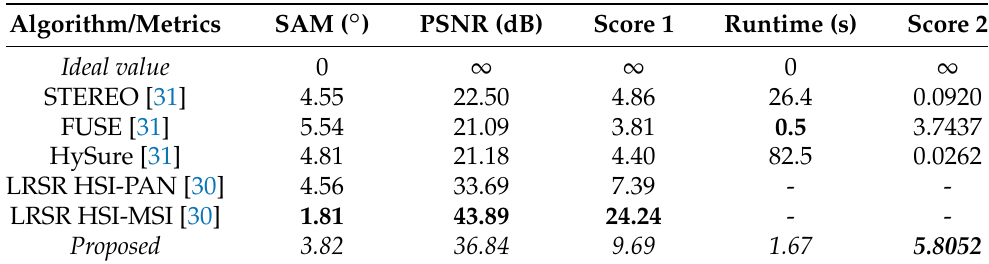
Table 2. Performance comparison of different SR algorithms on the Pavia University dataset. In bold the winner on each metric. Score 1 is defined in Equation (5) and Score 2 in Equation (6).